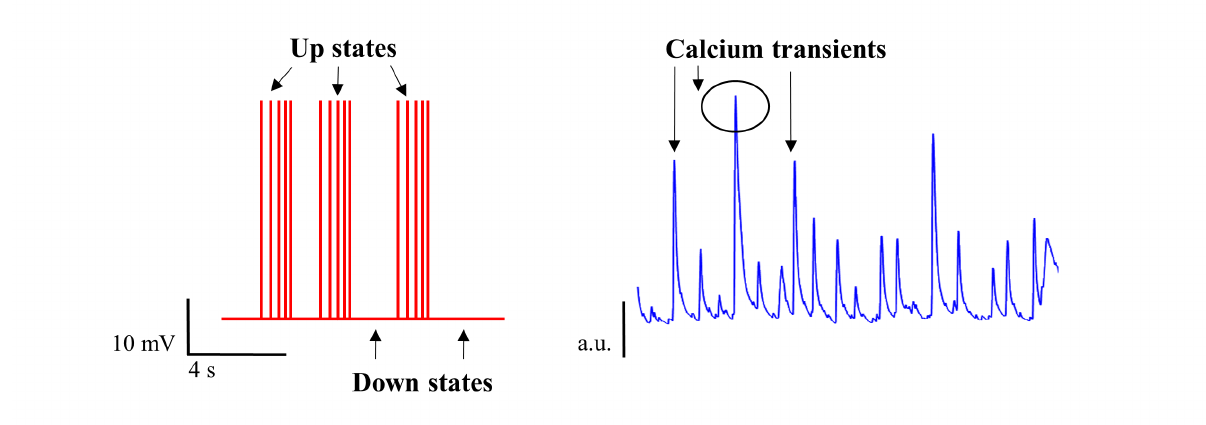
Figure 1. Schematic representation of spontaneous Up and Down states and calcium transients. The red trace on the left represents an example of a typical intracellular recording from a neuron in spontaneous conditions. Up and Down states are visible as rhythmic oscillations between membrane depolarization and hyperpolarization. The blue trace on the right depicts some typical calcium transients recorded from a single neuron in spontaneous condition. The time scale is the same for both traces. Note the increased duration of a single calcium transient comparing to a single Up state